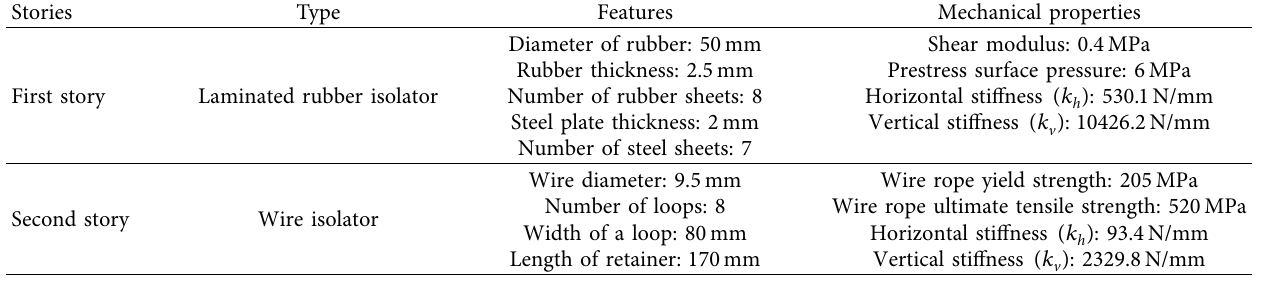
Figure 3: Details of an isolator system used in this study. (a) Front elevation. (b) Side elevation. (c) Plan of wire isolator. (d) Structure of rubber isolator. Table 1: Detailed characteristics of an isolator system used in this study.